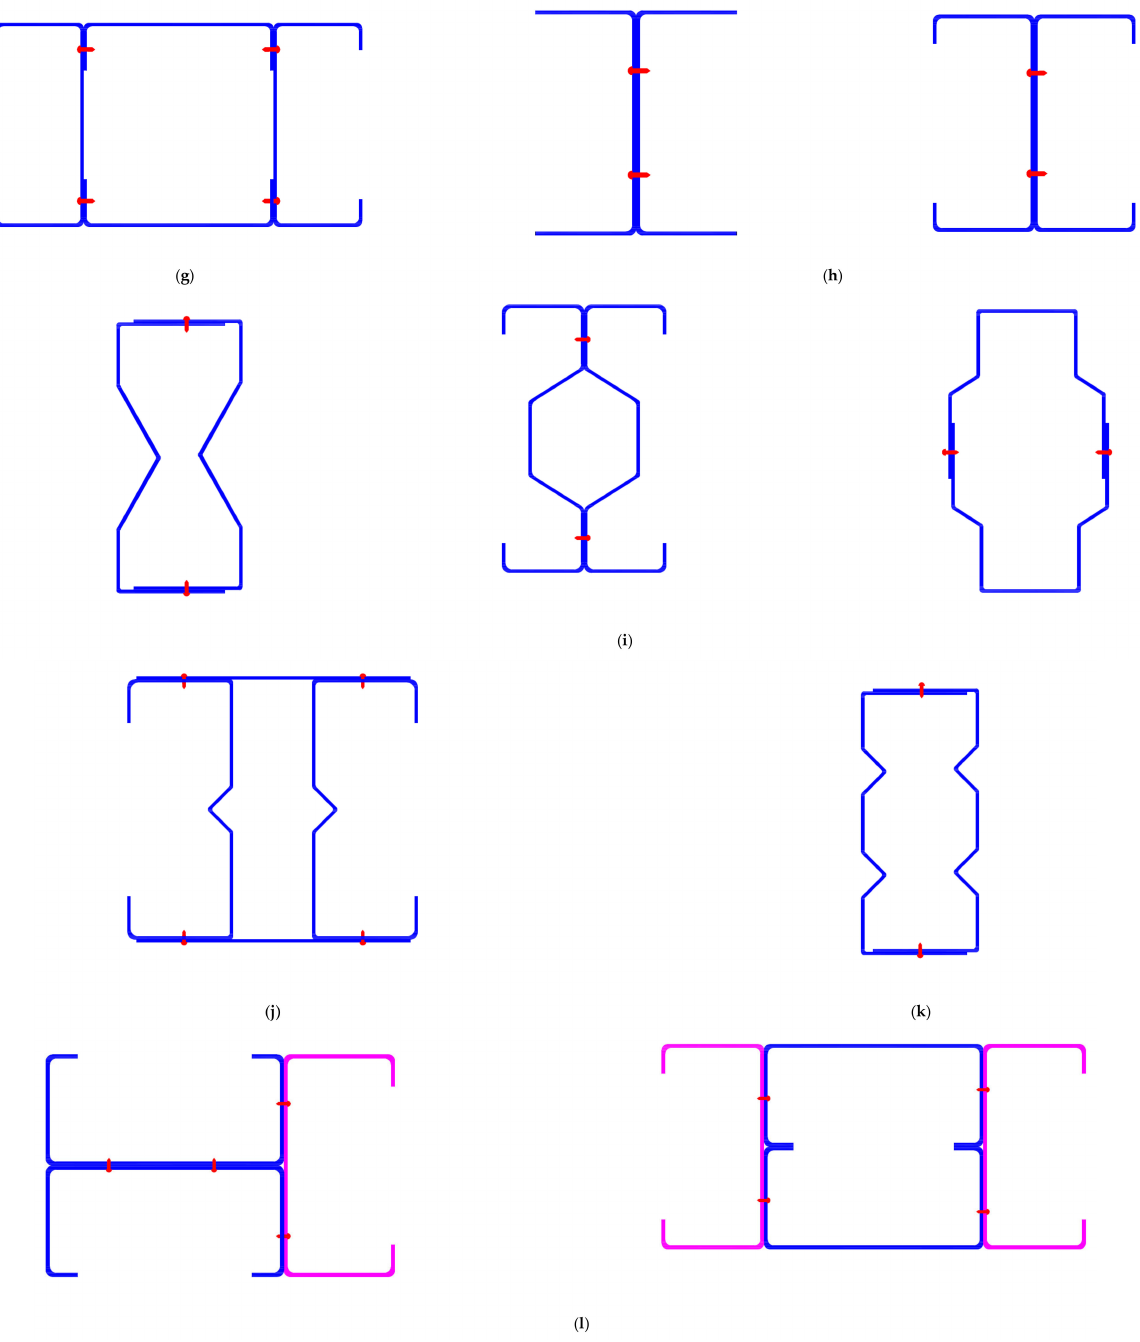
Figure 1. Cross-sections of CFS built-up channel sections from the literature. ( a )H.D.